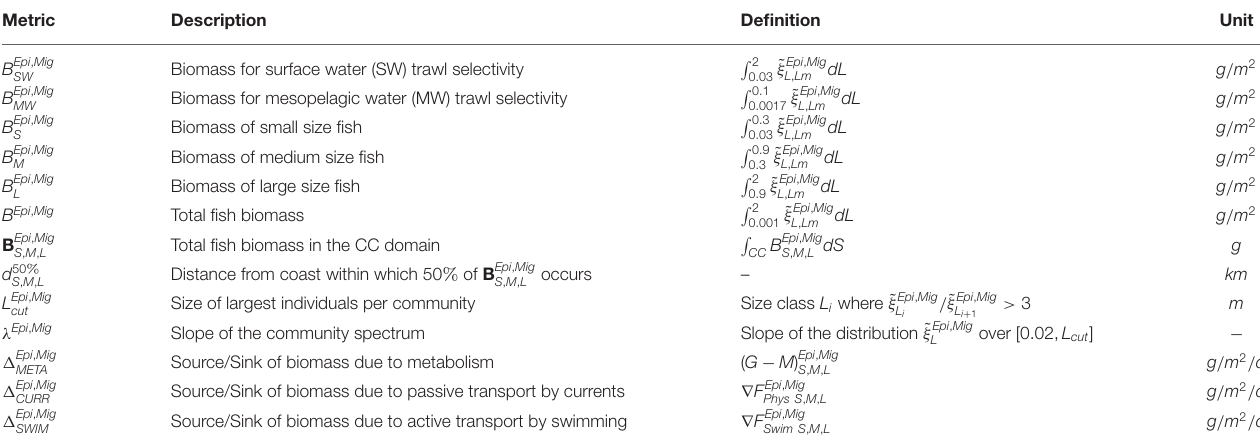
TABLE 2 | Metrics for the analysis of ecosystem features.